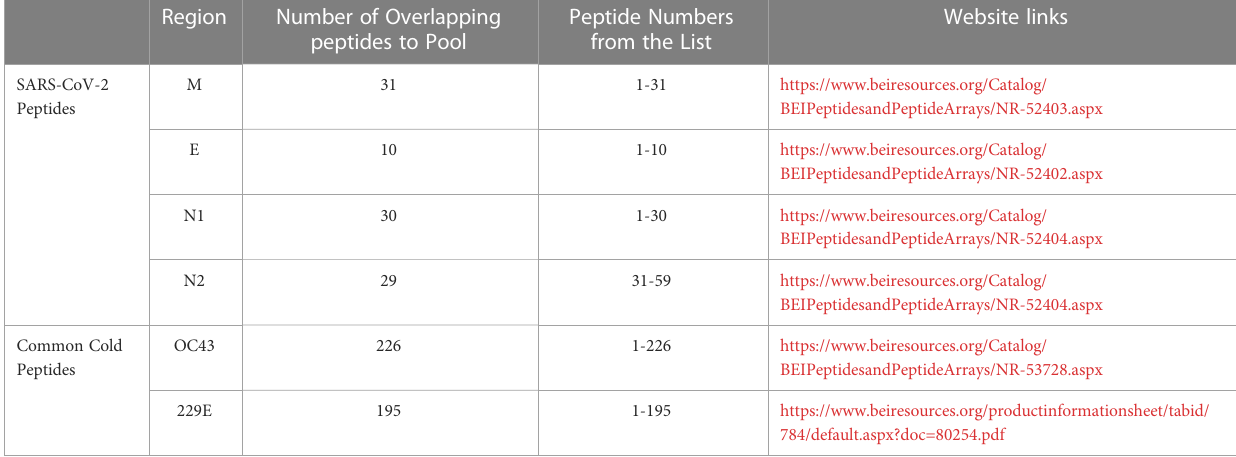
TABLE 1 Pooling arrangement of peptides from BEI Resources. Region Number of Overlapping peptides to